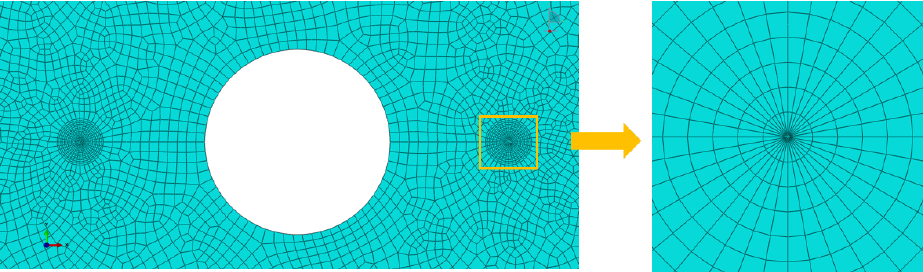
Figure 5. ( a ) Node offset of 8-node element. ( b ) ABAQUS crack singularity setting.